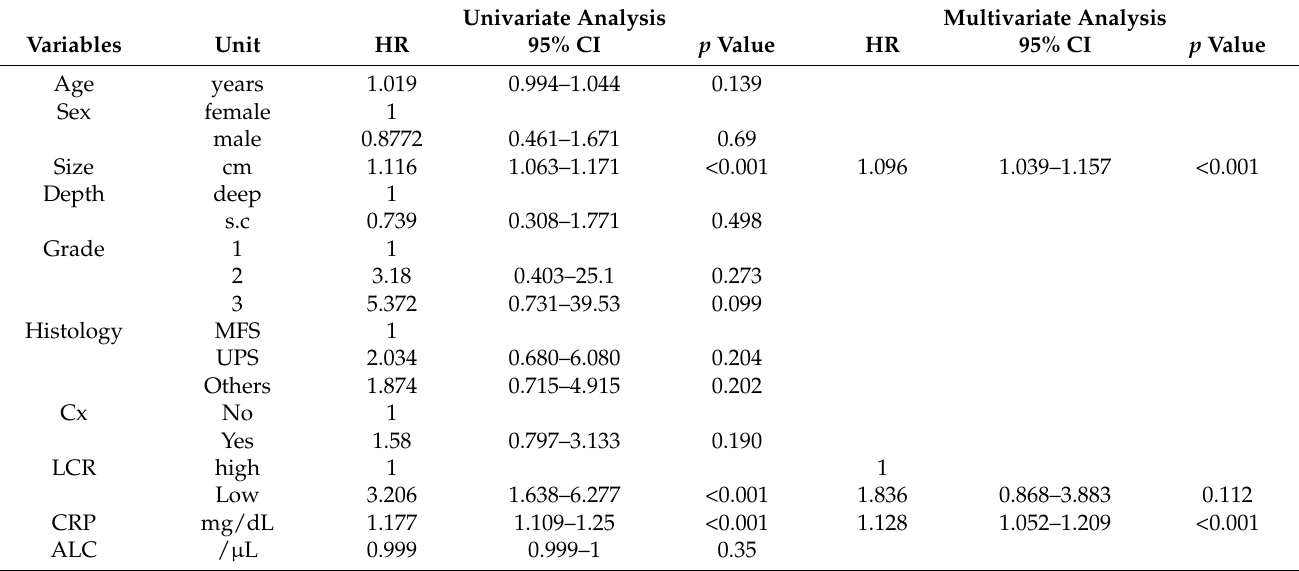
LCR: lymphocyte-to-C-reactive protein ratio, CRP: C-reactive protein, ALC: absolute lymphocyte count,